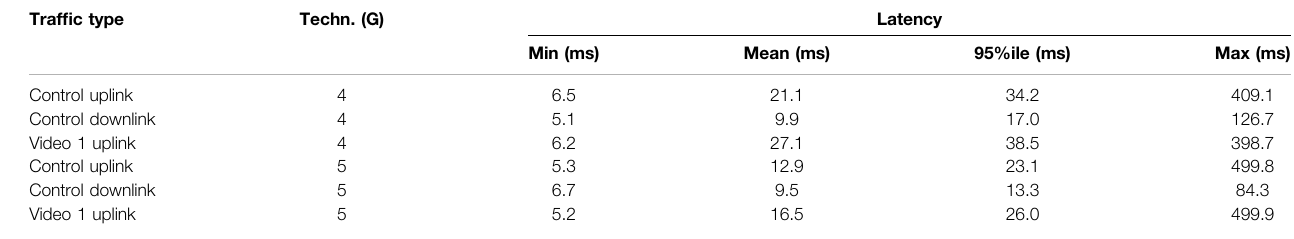
TABLE 3 | Connectivity results for the different traf fi c types and networks/technologies.